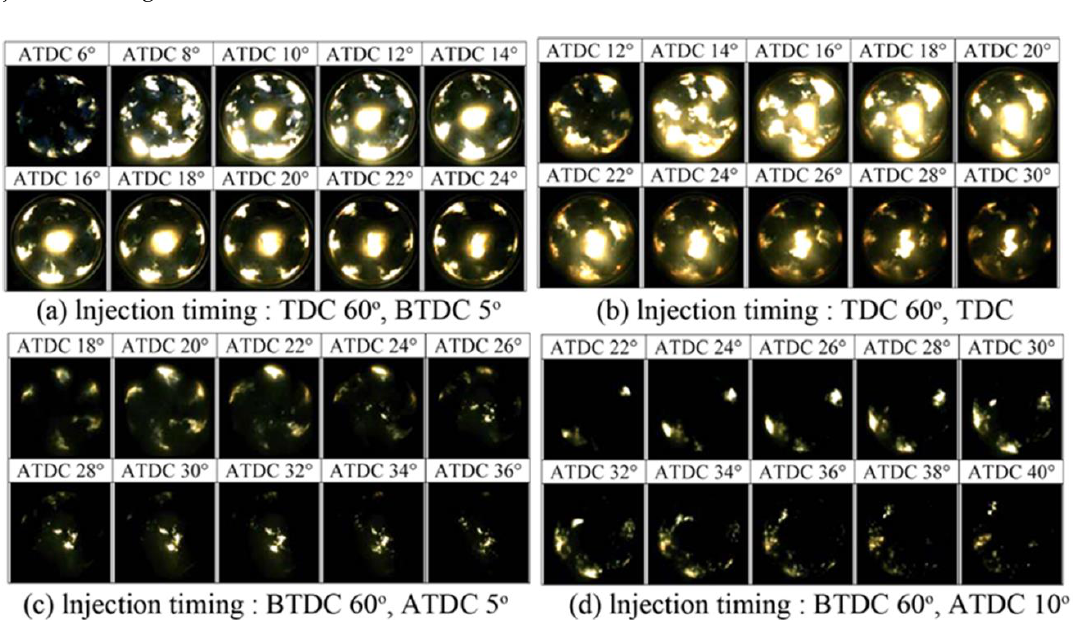
Table 5. Variation of performance and emissions after retarding the second injection timing (two- stage).